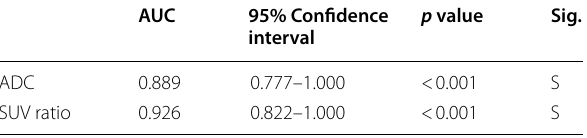
Table 3 Area under the curve of ADC and tumor ratio for detection of post‑TACE viable